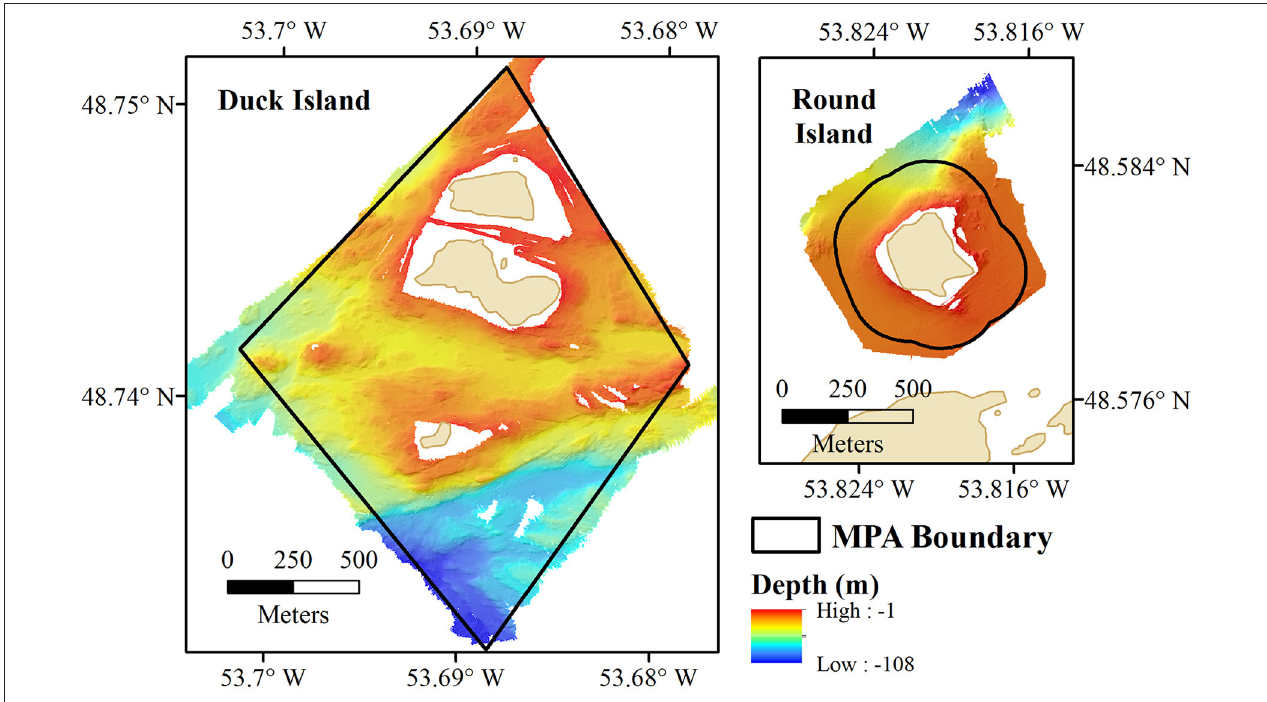
FIGURE 2 | Bathymetry within the Eastport MPA, visualized with hillshade effect.